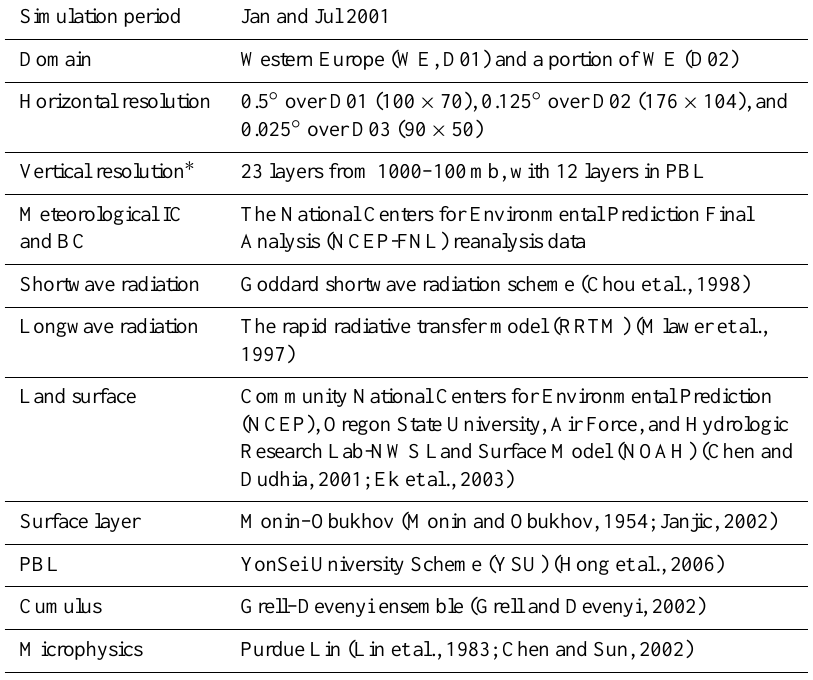
Table 2. Domain, configurations, and physical options used in